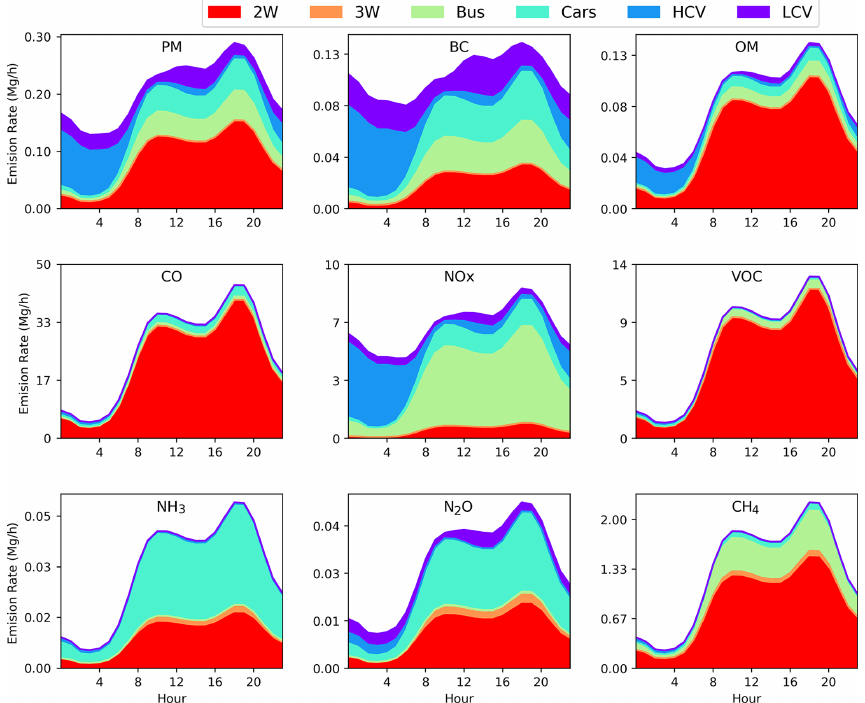
Figure 5. Variation of hourly emission (Mgh − 1 ) of the nine pollutants averaged across Delhi according to the major vehicle type. Different colours indicate the hourly contribution of each vehicle type to the total emission.